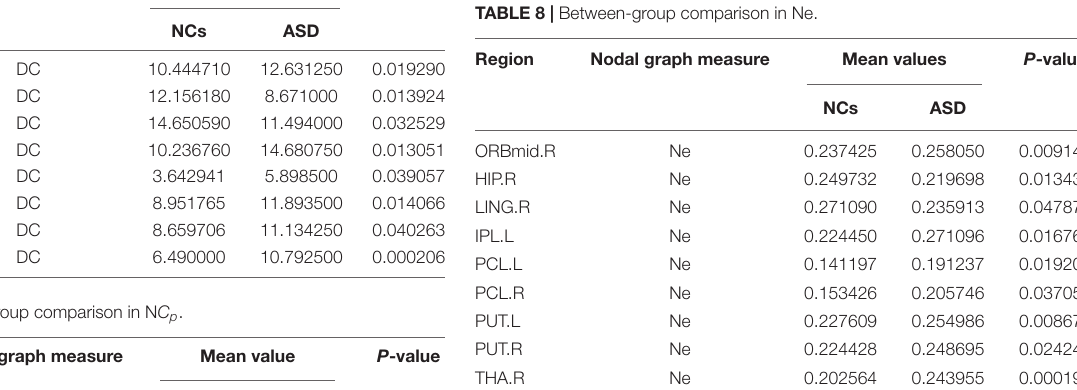
TABLE 5 | Between-group comparison in DC. Region Nodal graph measure